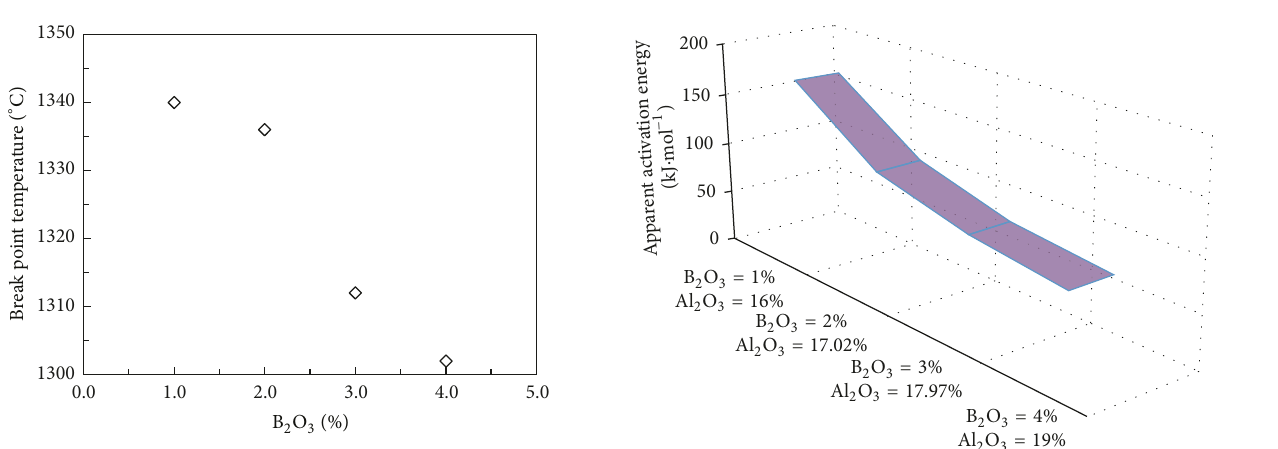
Figure 9: Relationship of apparent activation energy and B 2 O 3 and Al 2 O 3 content in